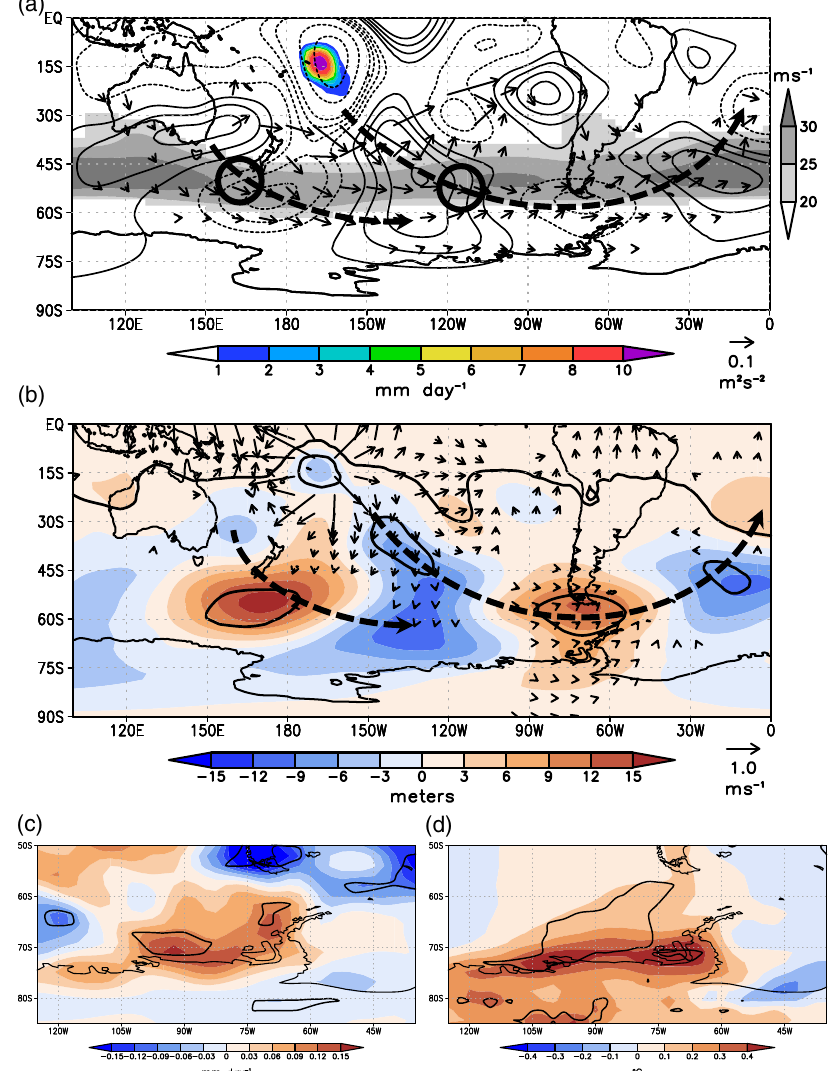
Fig. 4 The simulated atmospheric response to CPAC convection. The difference in CPAC perturbation minus control simulated 30-year climatologies for DJF. The difference in a total precipitation (color shaded), 200 hPa streamfunction (contour), and 200 hPa wave fl ux (vectors); b 500 hPa geopotential height (shaded) and 200 hPa divergent wind (vectors); c total precipitation, and d surface air temperature. In a , the 30-year climatological 300 hPa zonal wind from the control run is shaded in gray and the black circles schematically show the two regions of divergence in the exit region of the Indo-Atlantic jet streak and entrance region of the Paci fi c jet streak. In a , b , schematic arrows are drawn in black showing the two wave train paths. In b – d , bold black contours denote differences that are statistically signi fi cant at p < 0.10, and vectors in ( b ) are drawn only if at least one component of the divergent wind is signi fi cant at p <